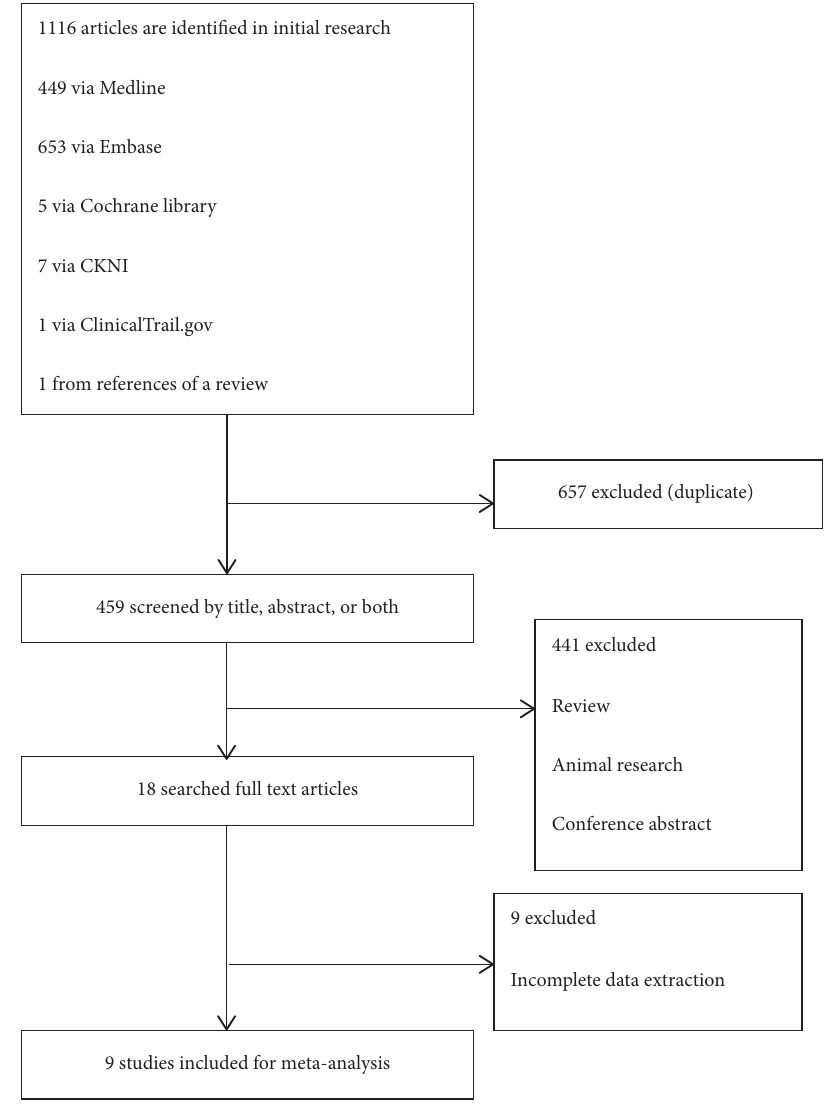
Figure 1: Flow diagram for the review process and outcomes of inclusion and